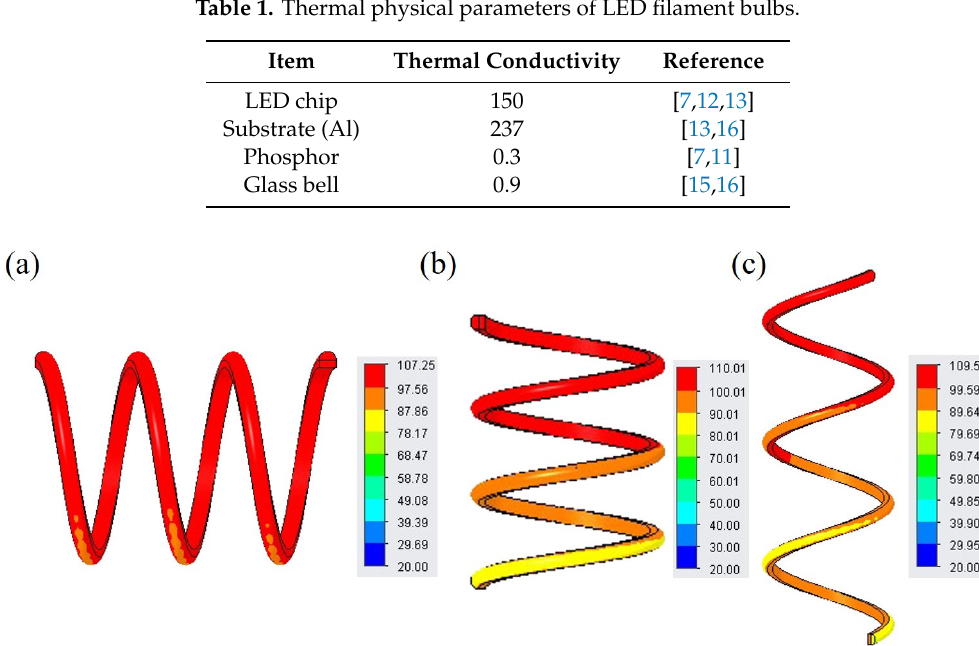
Figure 6. Temperature distribution of three different filament arrangements.